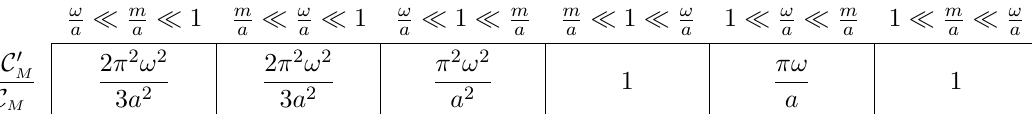
= C from the bound (E.5) in various regimes M M = C (cid:28) 1 in the ! (cid:28) a regime. (I.e. in M M